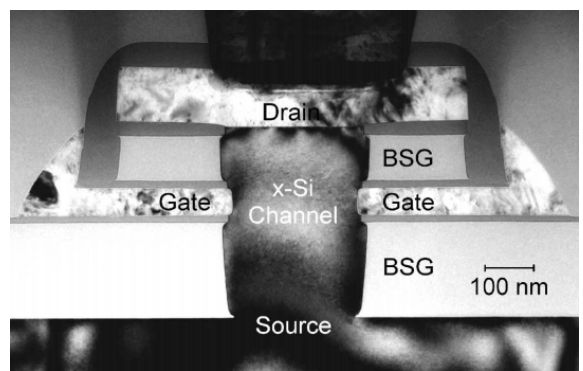
Figure 2. TEM cross-section of a Si channel vertical GAAFET (vGAAFET) with channel last or growth from bottom to top after the formation of bottom bottom borosilicate glass (BSG), gate layer, and top BSG layers [38].